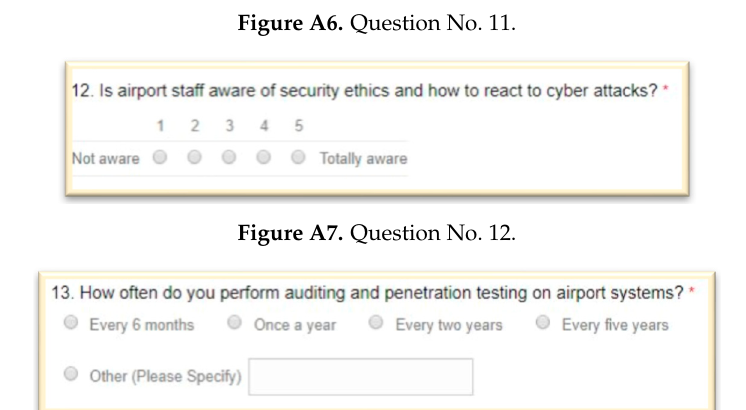
Sensors 2018 , 18 , x FOR PEER REVIEW 23 of 27